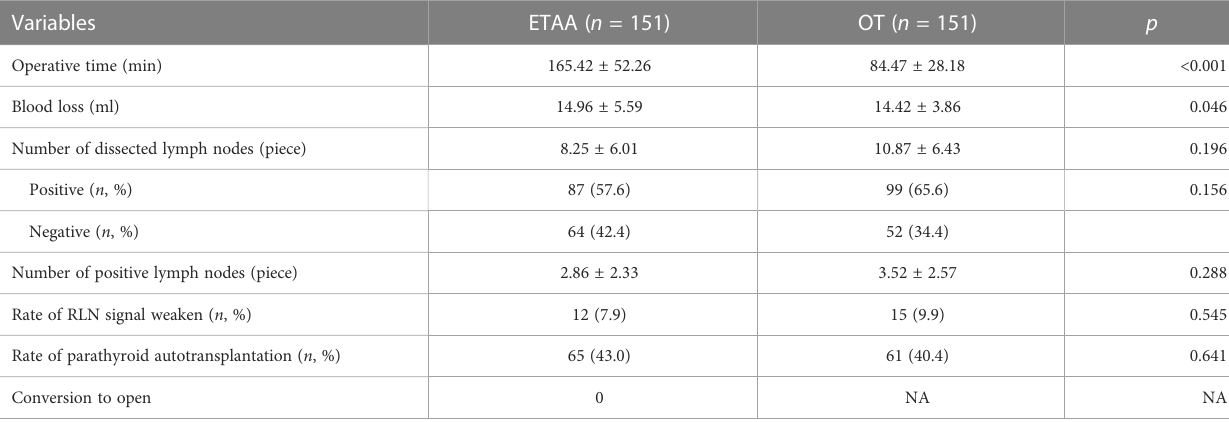
TABLE 2 Intraoperative